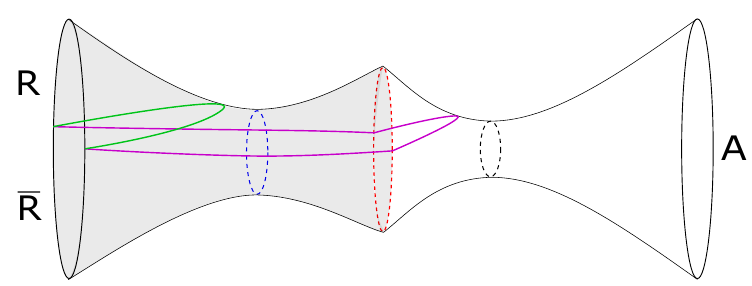
Figure 18 . An infalling geodesic (purple) and partial island for a subregion R of a single asymptotic radiation region R [ (cid:22) R . The green geodesic, which is contained entirely in the asymptotic BTZ patch of R [ (cid:22) R , has entropy S 1 , and the purple infalling geodesic has entropy S 2 . When the temperature of the inception black hole is large, the geodesic with entropy S 2 is the dominant RT